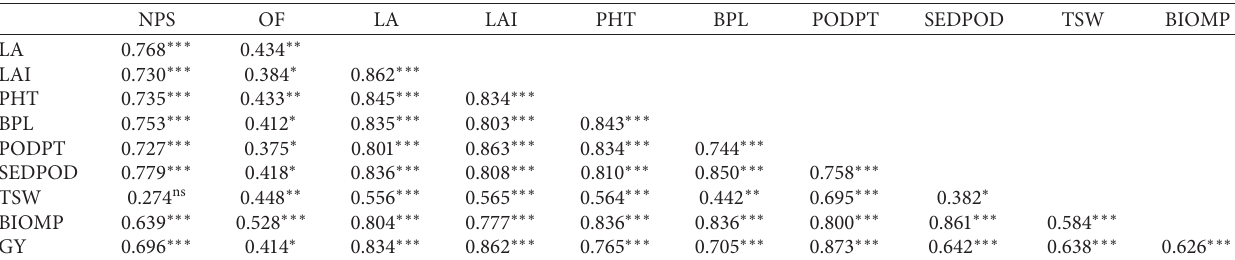
Table 4: Pearson correlation matrix of applied fertilizers and agronomic parameters.